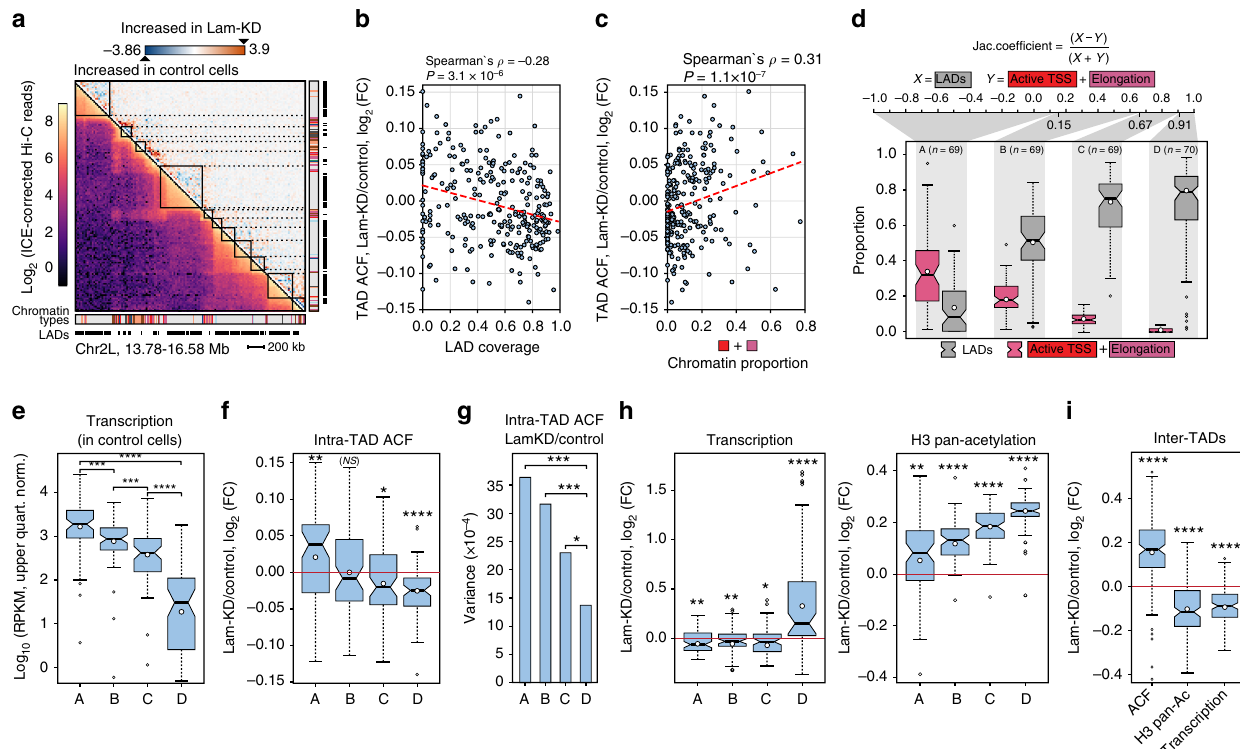
Fig. 3 TADs respond differentially to NL disruption. a Hi-C map showing a total chromatin interaction pro fi le (left half of the map), or subtraction map (Lam-KD - control) (right half of the map) at a 2.8-Mb region of chromosome 2 L. Chromatin annotation in S2 cells 40 and LADs annotation in Kc167 cells 28 are shown below. b , c Dependence of intra-TAD ACF changes upon Lam-KD on the LAD coverage ( b ), or on the proportion of “ red ” and “ purple ” chromatin types 40 ( c ) within these TADs. Trend line is in red. d Separation of TADs into four groups according to the Jaccard similarity coef fi cient. Box plots show the proportion of active chromatin ( “ red ” (active TSS) plus “ purple ” (elongation) chromatin types 40 ) and LAD coverage 28 within each group. e Transcription level in the four groups of TADs according to RNA-seq in control S2 cells. f Changes of intra-TAD ACF between Lam-KD and control cells in the four groups of TADs. g Variances of log 2 (FC) of the intra-TAD ACF upon Lam-KD compared to control cells in the four groups of TADs. *** P < 0.001, * P < 0.05 in a Levene ’ s test. h Changes of total transcription (left panel) and H3 pan-acetylation (right panel) levels between Lam-KD and control cells in the four groups of TADs. i Changes of ACF values, H3 pan-acetylation and total transcription in the inter-TAD regions between Lam-KD and control cells. See Fig. 1g legend for description of boxplot elements represented on panels ( d – f ), ( h ) and ( i ). In panels e , f , h , i , **** P < 0.0001, *** P < 0.001, ** P < 0.01, * P < 0.05, NS non-signi fi cant difference ( P > 0.05) in a Wilcoxon